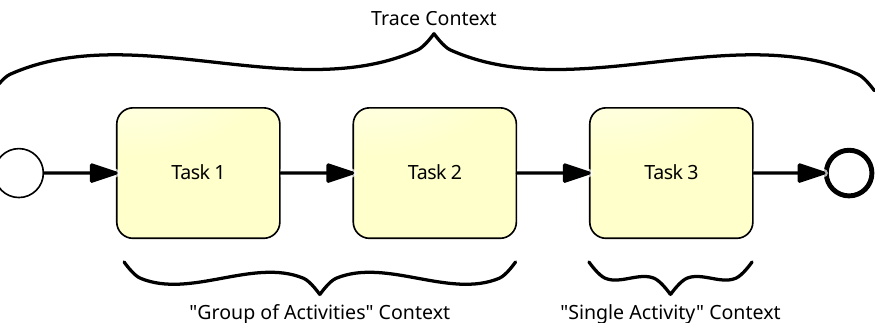
Figure 3. Different Contexts in Which IoT Data Can Be Collected.